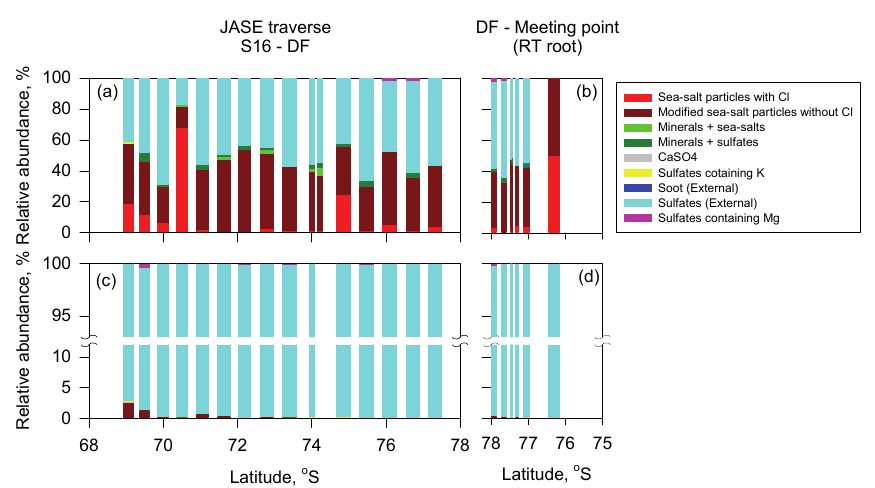
Figure 9. Horizontal features of relative abundance of each aerosol constituent in (a–b) coarse and (c–d) fine modes during the outgoing